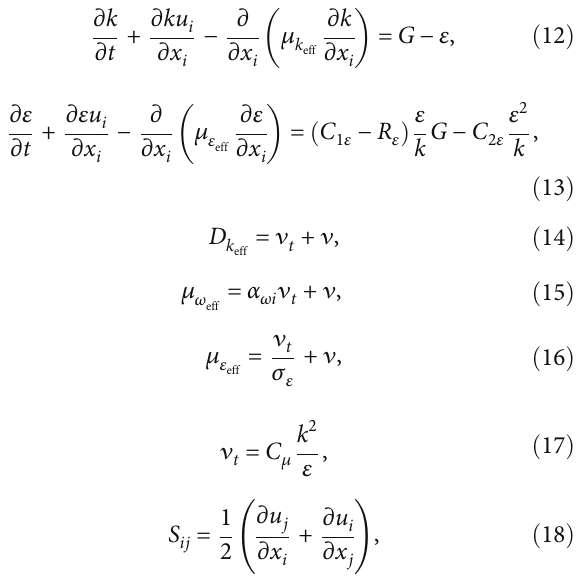
Table 5: Polynomial law of the maximum wave height. ffi ρ θ Coe